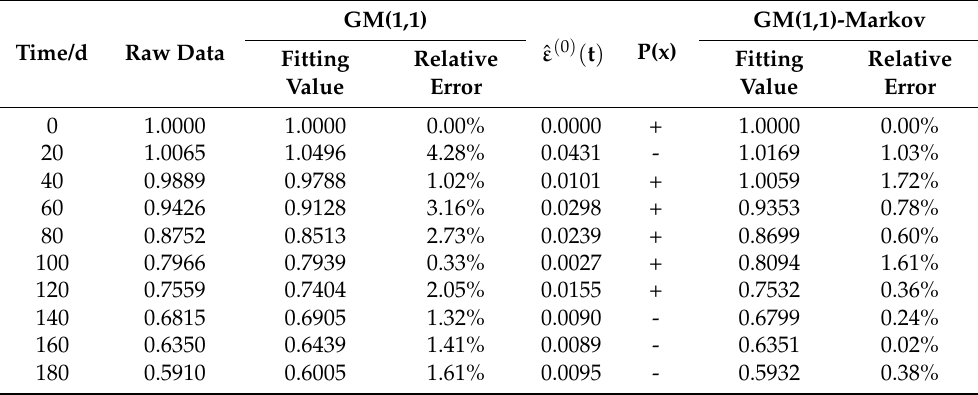
Table 5. Prediction results of OPC